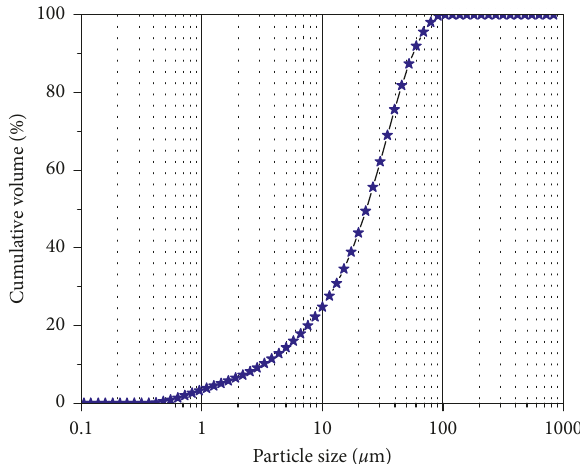
Figure 2: Particle-size distribution curve of WSA.